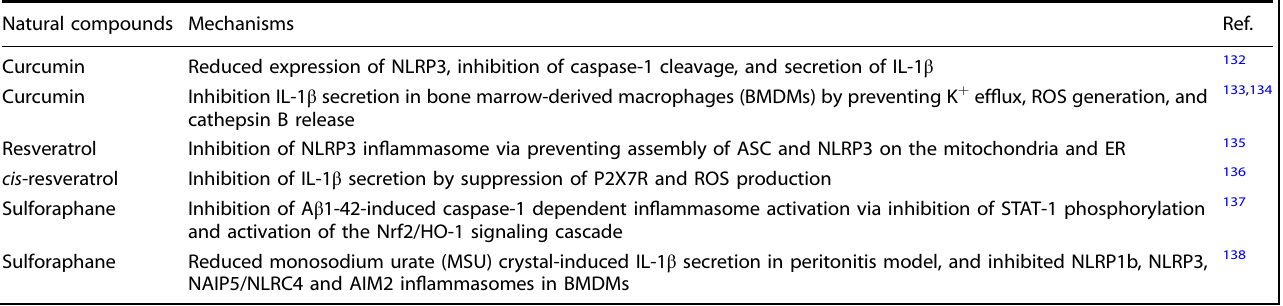
Table 2. Regulation of in fl ammasomes by natural compounds.